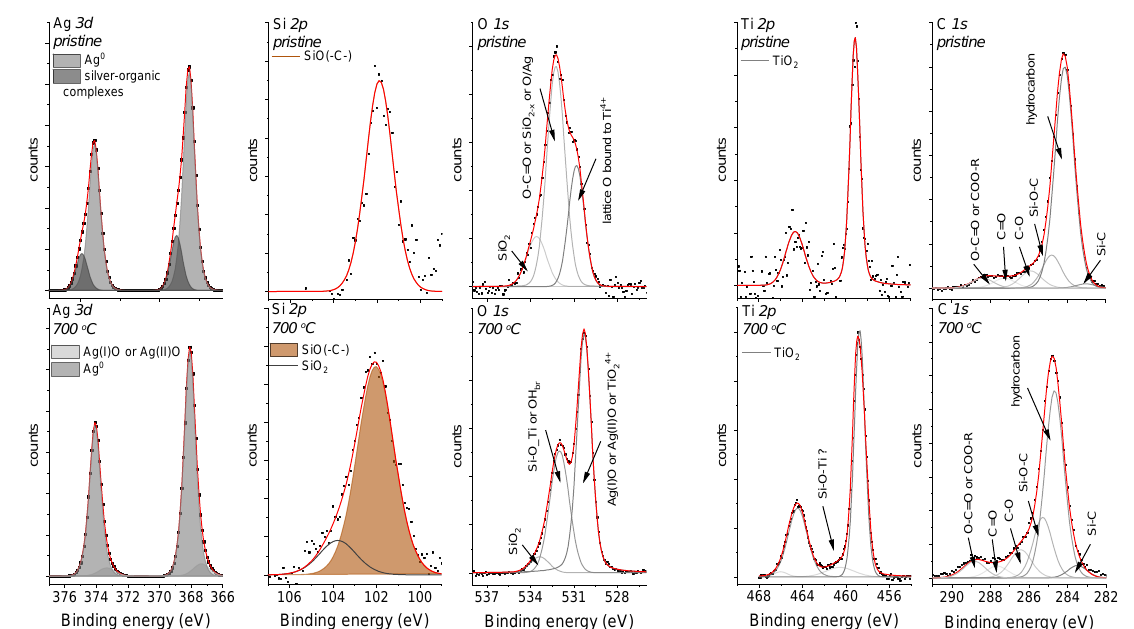
Figure 2. The Ag 3d , Si 2p , O 1s , Ti 2p, and C 1s core levels for the Ag-SiO 2 coatings that had been deposited on the TiO 2 /NiTi substrate that was obtained before ( upper panel ) and after ( lower panel ) sintering. The core levels were fitted using the Voigt function, and the background for each peak was subtracted using the Shirley baseline.